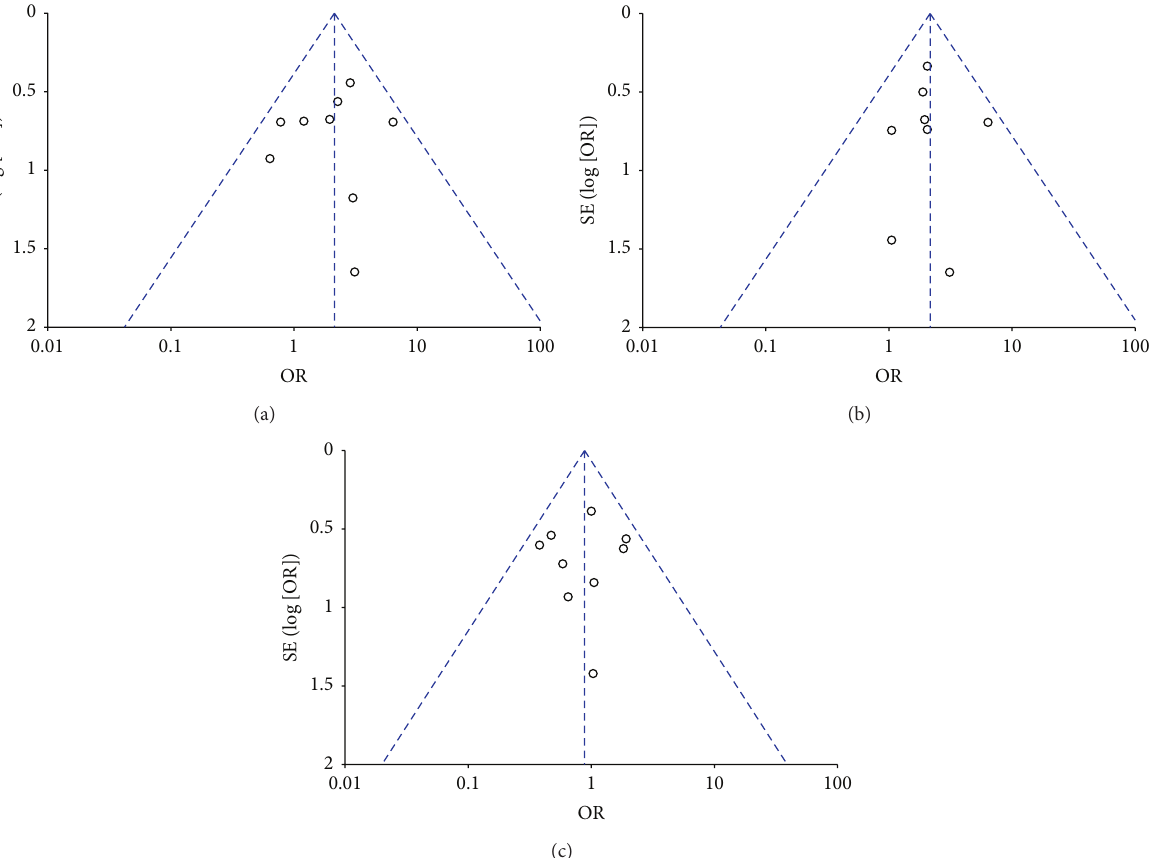
Figure 6: Funnel plot of publication bias. (a) En bloc resection rate, (b) complete resection rate, and (c) total complications.